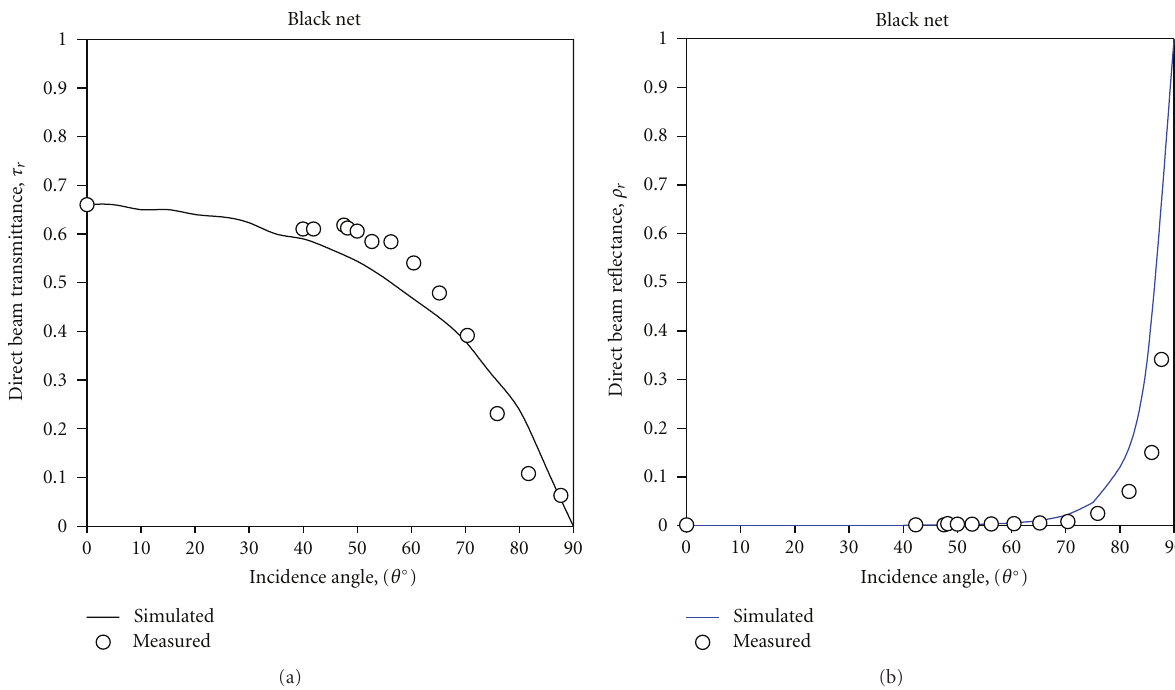
Figure 5: Comparison between the measured [8] and simulated values of (a) the direct beam transmittance ( τ r ) and (b) the direct beam reflectance ( ρ r ) for the black net.